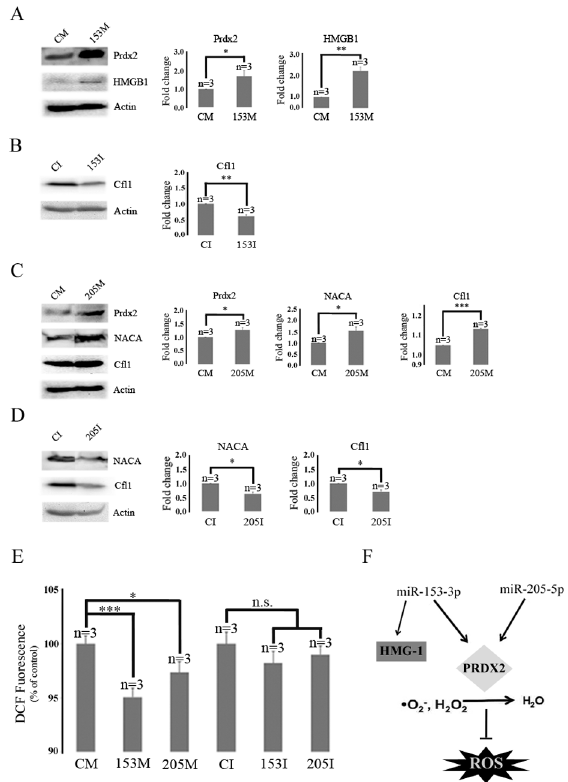
Fig 5. Verification of differentially expressed proteins by Western blot analysis and ROS changes in response to miR-153-3p and miR-205-5p. Western blot analysis showing effect of miR-153-3p mimic on (A) PRDX2 and HMGB1 levels (B) effect of miR-153-3p antagomir on Cfl1 levels, (C) effect of miR-205-5p mimic on PRDX2, NACA and Cfl1 levels, (D) effect of miR-205-5p antagomir on NACA and Cfl1 levels. (E) Quantification of ROS levels in SH-SY5Y cells by modulating miR-153-3p and miR-205-5p levels. Percentage change in DCF fluorescence compared to control is shown. (F) Proposed pathway for ROS reduction due to miR-153-3p and miR-205-5p by regulation of PRDX2. Error bars indicate SEM (n = 3); * , p < 0.05; ** , p < 0.01, *** ; p < 0.001.